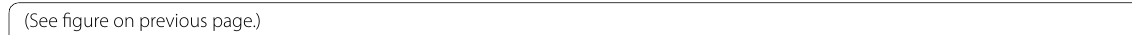
Table 1 Primers used for the PCR amplification of the hsp 70 gene of Streptomyces strains